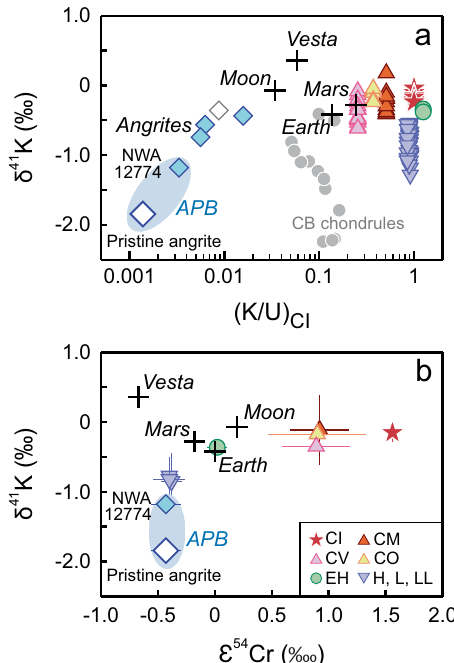
Fig. 4 | Potassium isotopic compositions of the angrite parent body (APB) compared with other planetary materials. In a the extremely low K/U ratio and δ 41 K value of the APB do not resemble any of the known planetary materials; therefore, these characteristics are not inherited from the precursor of APB. In b , the widely divergent δ 41 K signatures of the APB and Vesta, despite their similar nucleosynthetic ε 54 Cr anomalies, suggest that δ 41 K values are controlled by volatility-dependent fractionations rather than nucleosynthetic anomalies. The plotted δ 41 K values for chondrite witnessed falls and chondrules include data from thisstudyandthosefromtheliterature(refs.27 – 31,68).Individualdataareplotted in a .Errorbars(95%c.i.)aretypically similar toor smallerthan thesamplesymbols and are omitted for clarity. Group averages are plotted in b with associated 2SD. The δ 41 K values of differentiated planetary bodies are also plotted for comparison (refs. 11, 12, 24, 33, 34). The K/U ratios are from ref. 8., except those for angrites (from this study) and those for CB chondrules (from ref. 29). The average nucleo- synthetic ε 54 Cr anomalies and associated 2SD are from refs. 56, 69. The blue fi elds indicate the δ 41 K rangeinferredfor the APB, which is bounded by the extrapolated value for pristine angrite (shown in open diamond symbol with dark blue border) and the isotopicallylightestangrite measured inthis study(NWA 12774). The open diamond symbol with grey border denotes angrite NWA 12320 that might be affected by aqueous